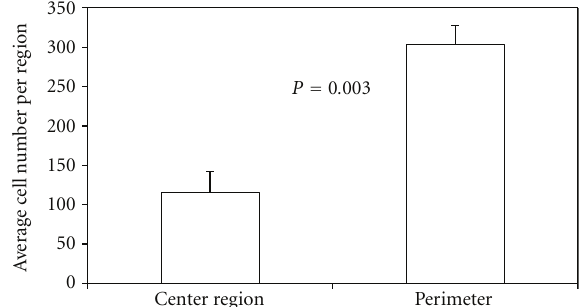
Figure 5: Cell number is lower in the middle region of three- dimensional sca ff olds cultured statically for 14 days. Periphery is mean value of the 8 peripheral regions.